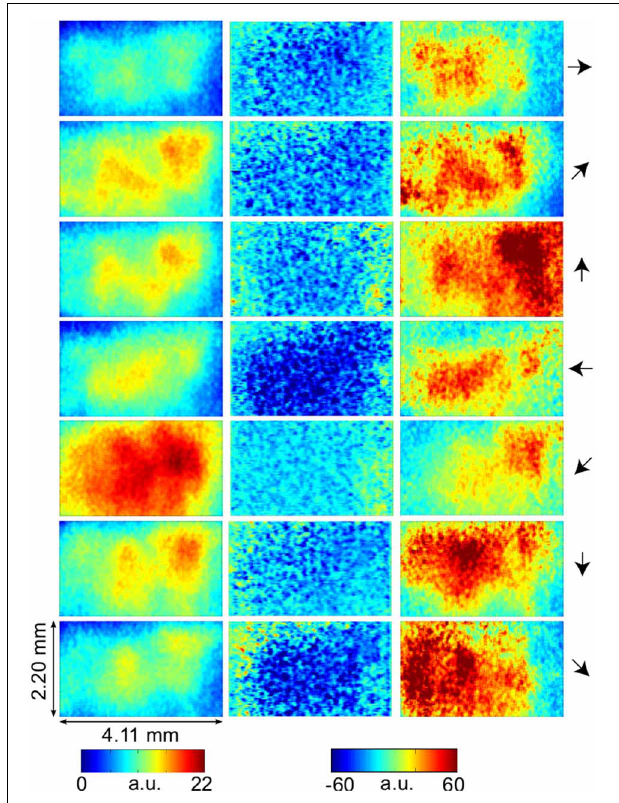
FIGURE 2 | VSD-activity and local active information storage (LAIS) maps. VSD activity averaged over stimulation epochs and time after stimulus onset after the initial transient (0.2–1s) (left column). LAIS map immediately after stimulus onset—negative values (blue) indicate surprise of the system (middle column). Time-average LAIS maps from the stimulus period after the initial transient (0.2–1s) (right column). Rows 1–7 present different stimulus motion directions: 0, 45, 90, 180, 225, 270, 315 (in degrees, indicated by arrows on the right, arrow colors match time-trace colors in Figure 3 ). 67 × 137 data pixel per image, pixel dimension 30 × 32 μ m 2 . Left–right image direction is anterior–posterior